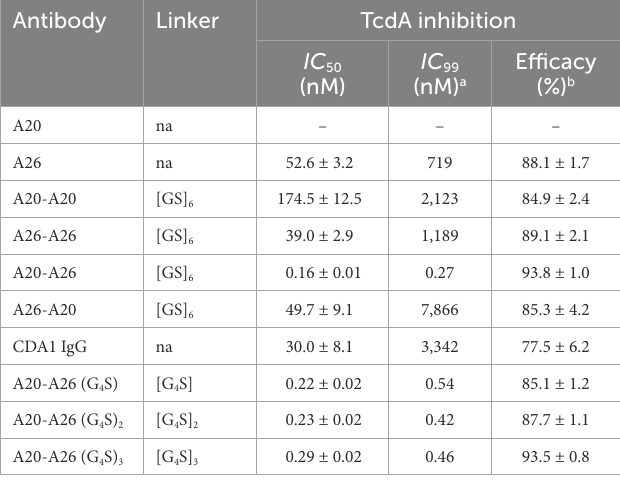
TABLE 2 TcdA neutralizing potency and efficacy of V H H constructs. Antibody Linker